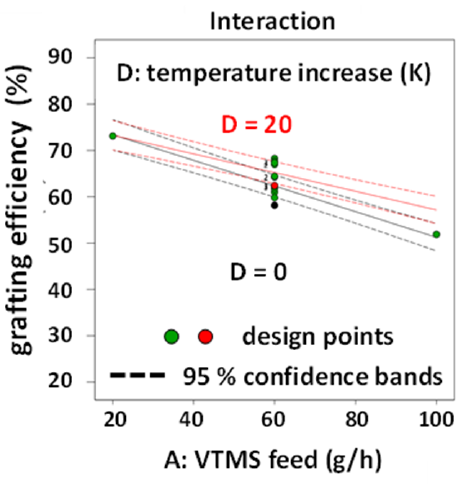
grafting process achieved here was > 80%. Figure 7 shows that there is a broad region of possible factor level combinations available in the design space that results in grafting e ffi ciencies well beyond 60%.